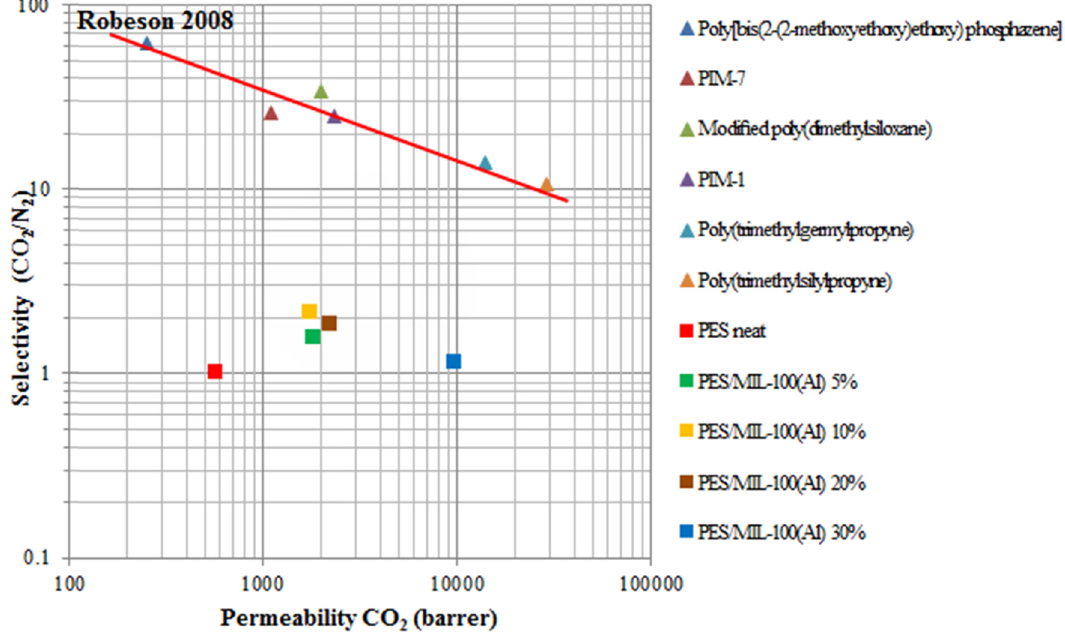
Figure 16: Comparison of CO 2 /N 2 gas separation performance as compared with the literature [ 49 ]